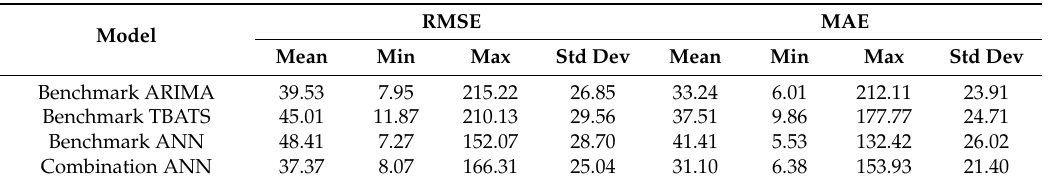
Table 8. ANN method results.